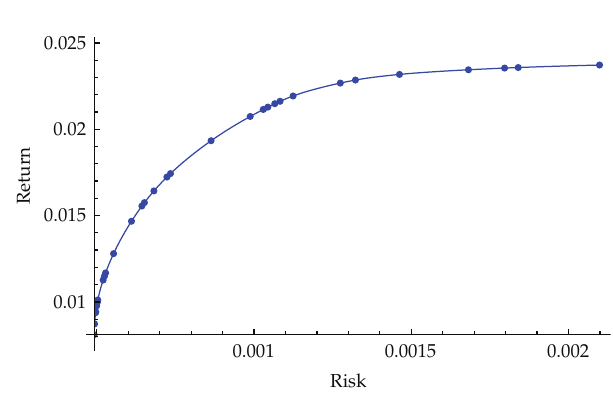
Figure 3: The exact e ffi cient frontier of a problem with 88